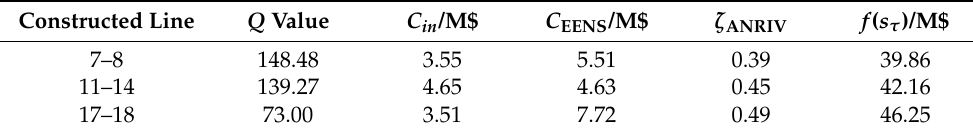
Figure 10. Q value of each action under the existing network structure. Table 2. Comparison of indexes and costs under three line-building